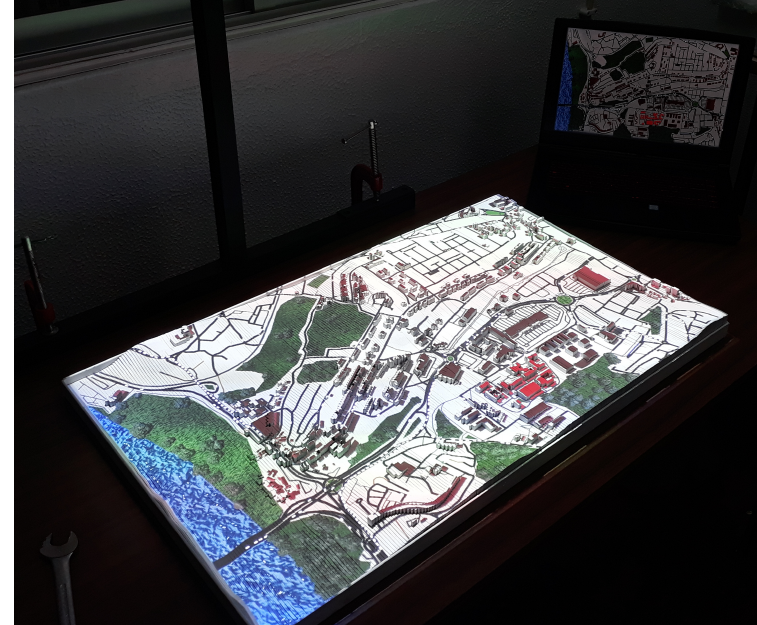
Figure 6. Physical model, with the projection of the city model over the wooden structure and showing the computer screen behind for